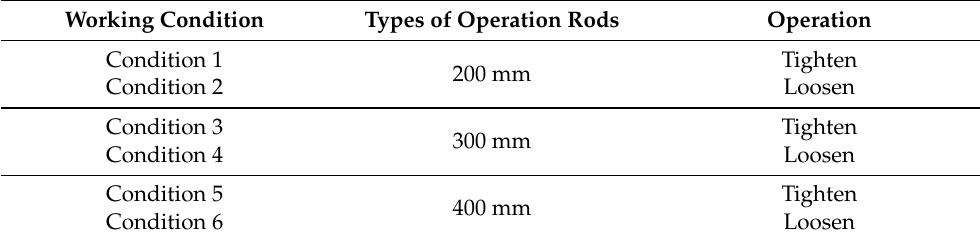
Table 1. Six working conditions of the